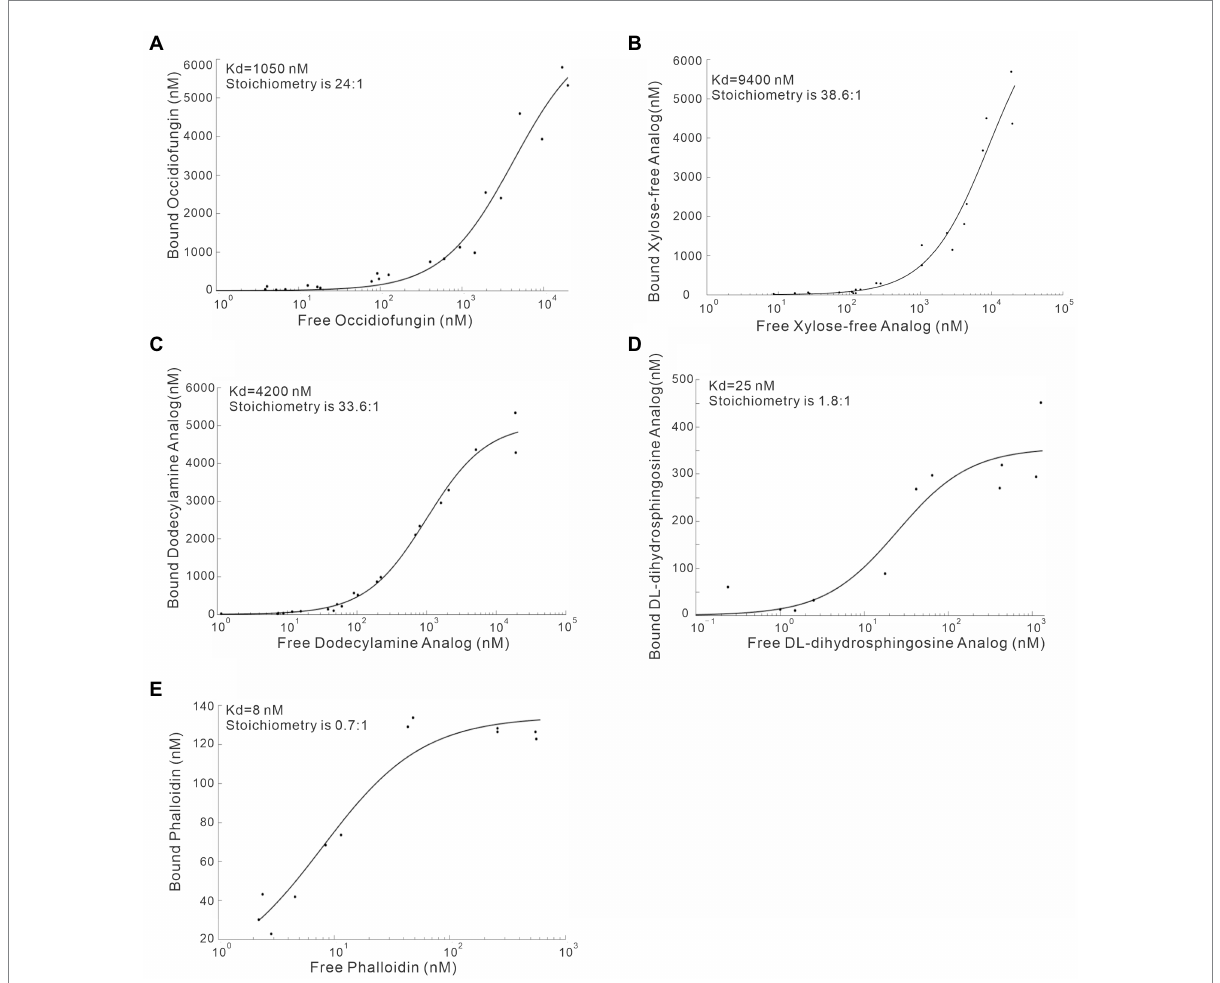
FIGURE 6 Co-sedimentation assay demonstrating the binding of occidiofungin analogs to actin. (A) Binding curve of native occidiofungin to actin (Kd = 1,000 nM; the stoichiometry [ligand: protein] is 25: 1. (B) Binding curve of xylose free occidiofungin to actin (Kd = 9,400 nM; the stoichiometry [ligand: protein] is 38.6: 1. (C) Binding curve of the dodecylamine analog to actin (Kd = 4,200 nM; the stoichiometry [ligand: protein] is 33.6: 1. (D) Binding curve of the DL-dihydrosphingosine analog to actin (Kd = 25 nM; the stoichiometry [ligand: protein] is 1.8: 1. (E) Binding curve of phalloidin to actin (Kd = 8 nM; the stoichiometry [ligand: protein] is 0.7: 1. The graph is plotted between the amount of free compound obtained in the supernatant of the co-sedimentation assay and the amount of bound compound obtained from the actin pellet. Data for native occidiofungin and phalloidin has been published previously (Ravichandran et al.,